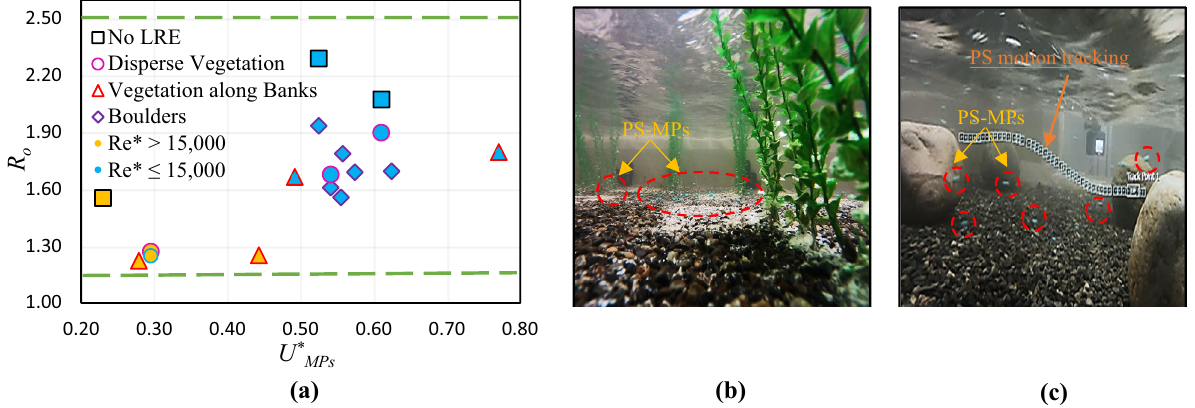
Figure 3. ( a ) The relationship of Rouse number (Ro) and dimensionless microplastics velocity ( U ∗ MPs ), with yellow highlighted dots (Re* > 15,000); ( b ) observations of PS-MPs’ movement/ settlement in vegetation zone (B2); and ( c ) observations of PS-MPs’ movement/ settlement in boulder zone (D5) (the motion of PS-MPs highlighted with the sequence of squares).